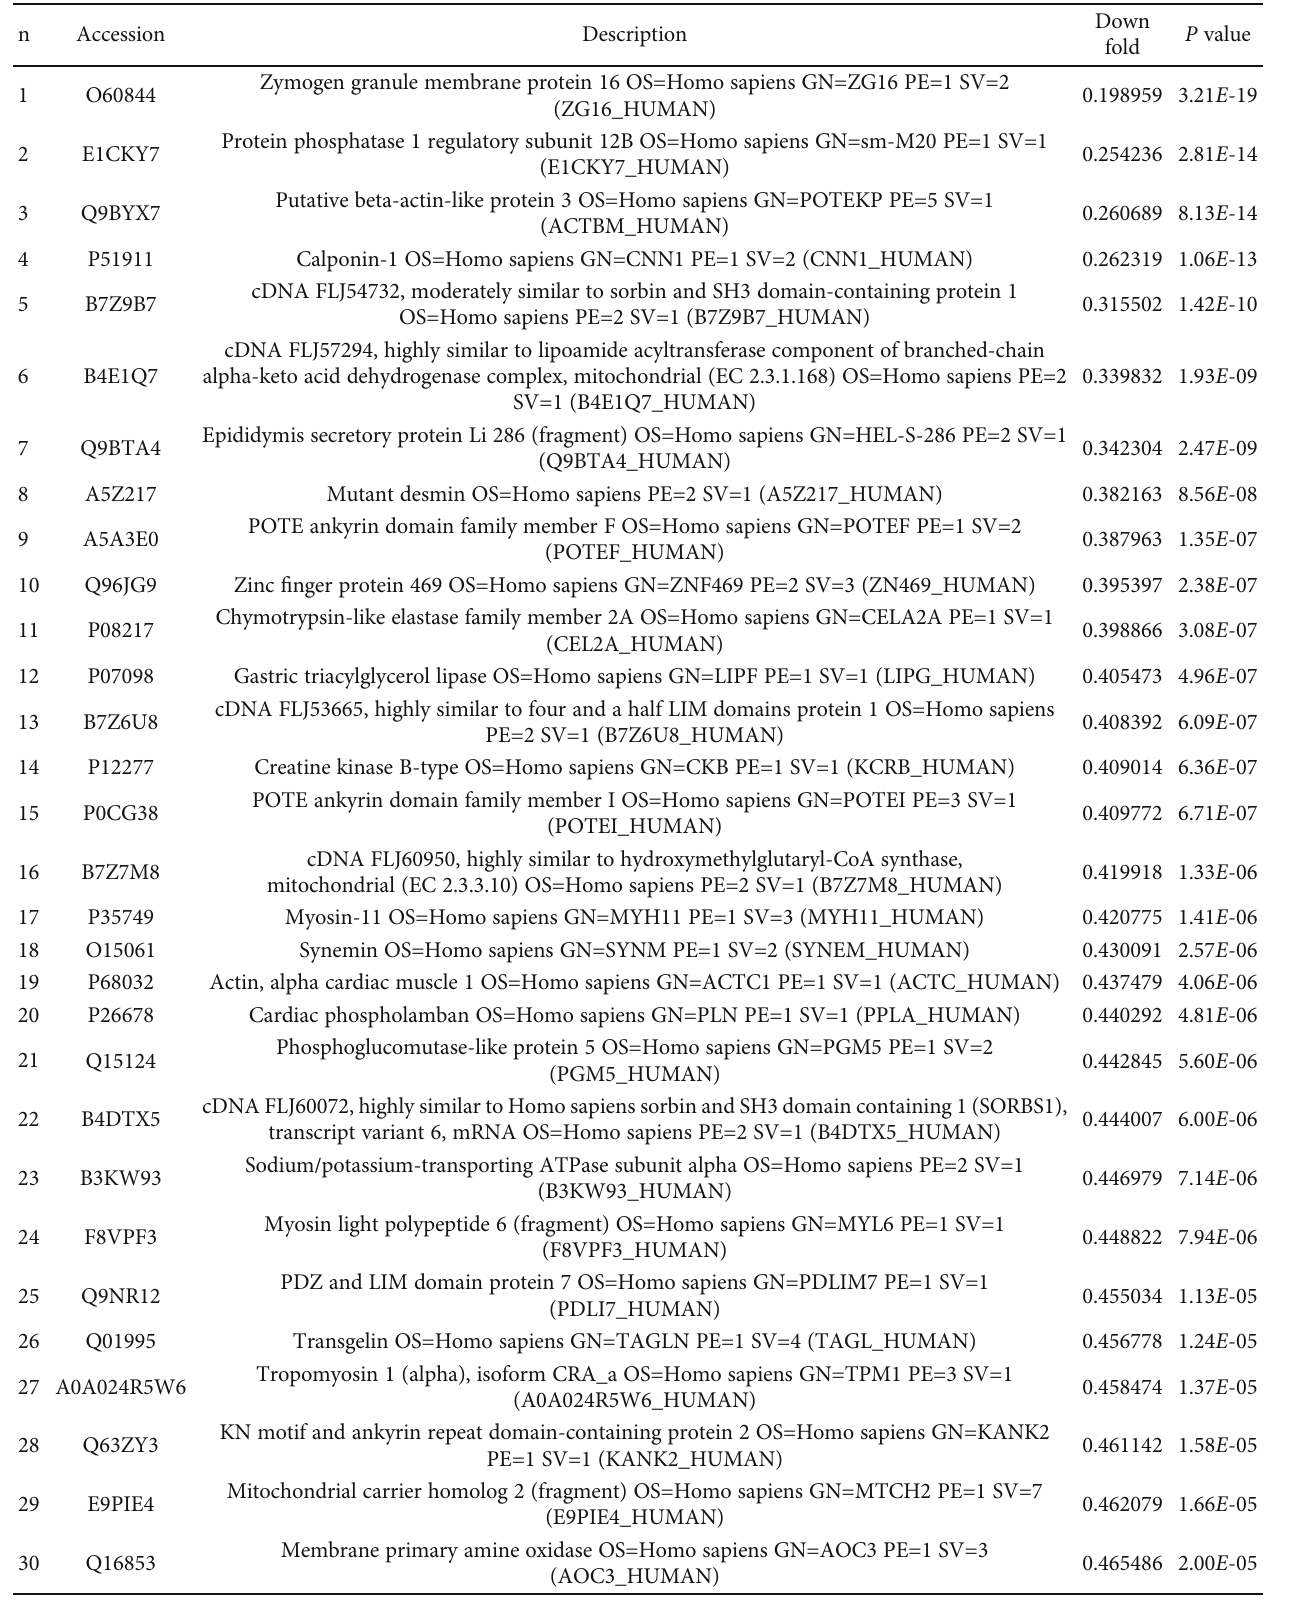
Table 2: The top 50 proteins with downregulation folds less than